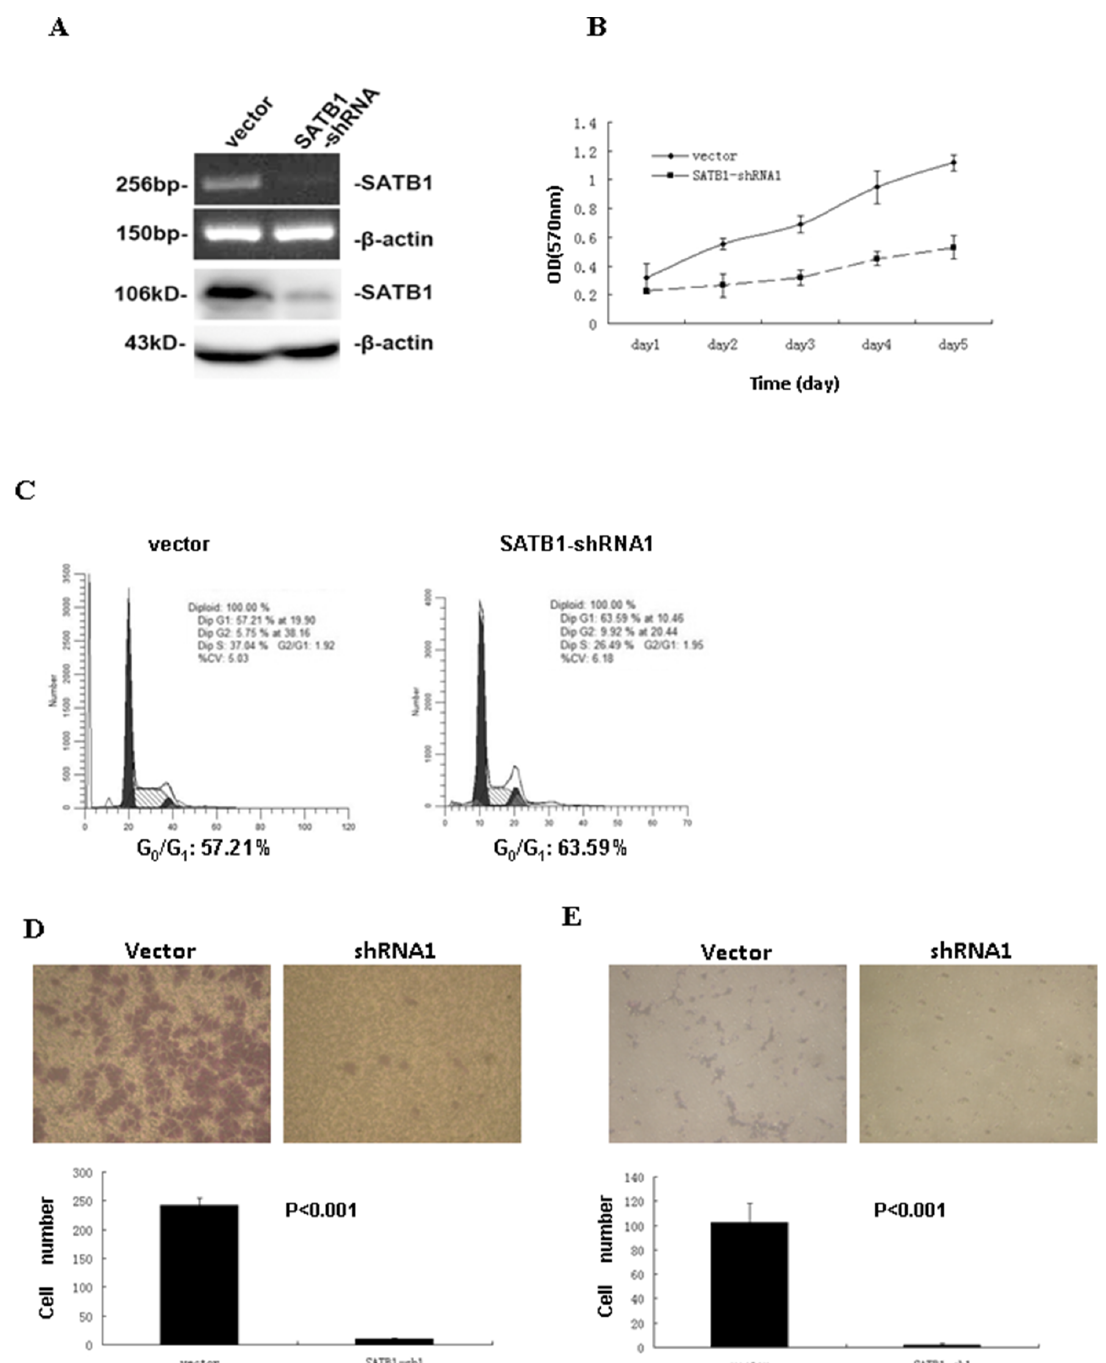
Figure 3. In RKO cell lines, knockdown of SATB1 expression reduces cell proliferation, migration, and invasion in vitro. (A) SATB1- knockdown RKO cell lines was established using shRNA1. Cells transfected with empty vector served as controls. The efficacy of SATB1 knockdown was verified by RT-PCR and western blot. b -actin was used to ensure equal loading. (B) Cell proliferation of empty vector control, and SATB1-shRNA1 RKO cells was determined by MTT assay. (C) Flow cytometry analysis of cell cycle in empty vector control, SATB1-shRNA1 RKO cells. (D) Migration of empty vector control, SATB1-shRNA1 RKO cells was determined by transwell migration assay. *p , 0.001, number of migrated cells compared to control. (E) Cell invasion of empty vector control, SATB1-shRNA1 RKO cells was determined by Matrigel transwell invasion assay. *p , 0.001, number of invaded cells compared to control. doi:10.1371/journal.pone.0100413.g003 in the lower chamber as a chemoattractant. After incubation for the underside of the filter membrane were fixed and stained with 24 h, non-migrated cells in the upper chamber of the transwell 0.1% crystal violet. The number of migrated cells was counted in 5 insert were removed with a cotton swab, and the migrated cells on randomly selected microscopic fields and photographed. The